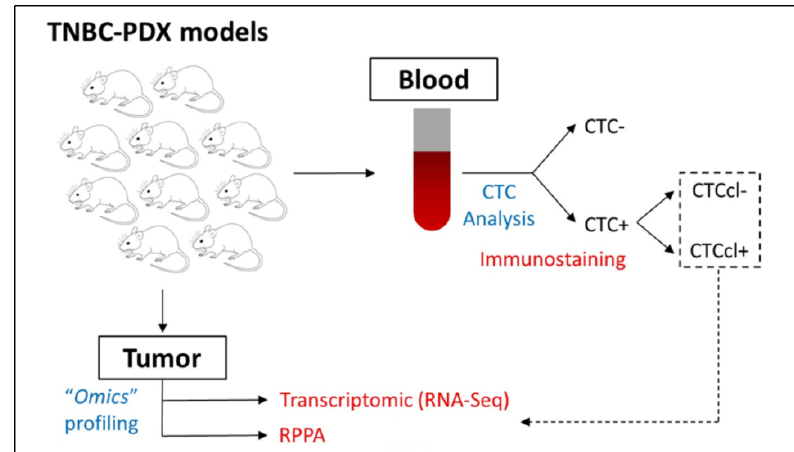
Figure 1. Outline of experimental design. Workflow showing detection of circulating tumor cells (CTCs) and CTC clusters (CTCcls) from patient-derived xenograft (PDX) blood using immunofluorescence staining. The reverse-phase protein array (RPPA) and transcriptomic data from PDX tumors with versus without CTCcls were interrogated and analyzed to identify differentially expressed proteins and genes.